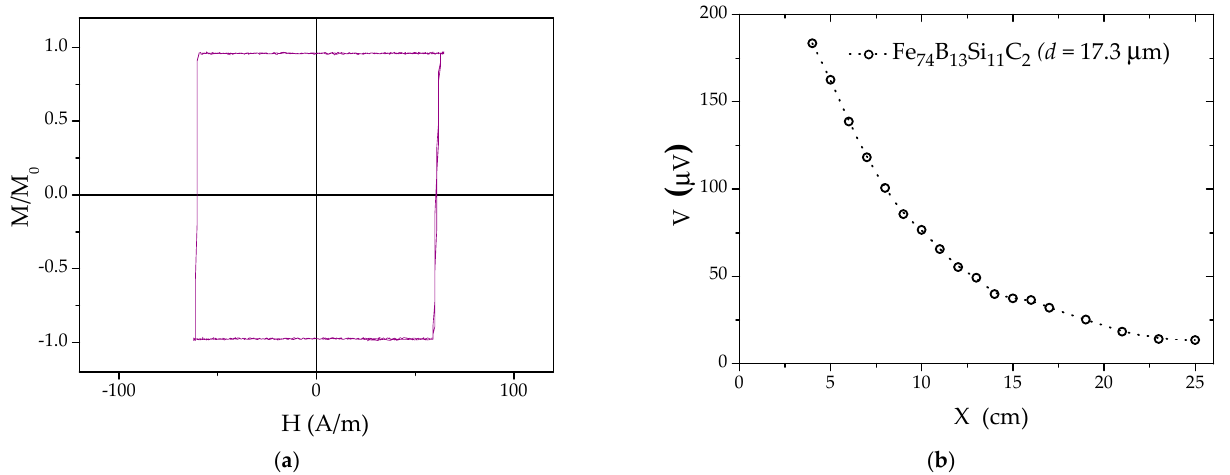
Figure 2. Hysteresis loop ( a ) and the amplitudes of the fifth harmonics generated by a 3 cm long Fe 74 B 13 Si 11 C 2 microwire with diameter d = 17.3 μ m as a function of the distance from the pick-up coil ( b ). Figure 2b is adapted [47].